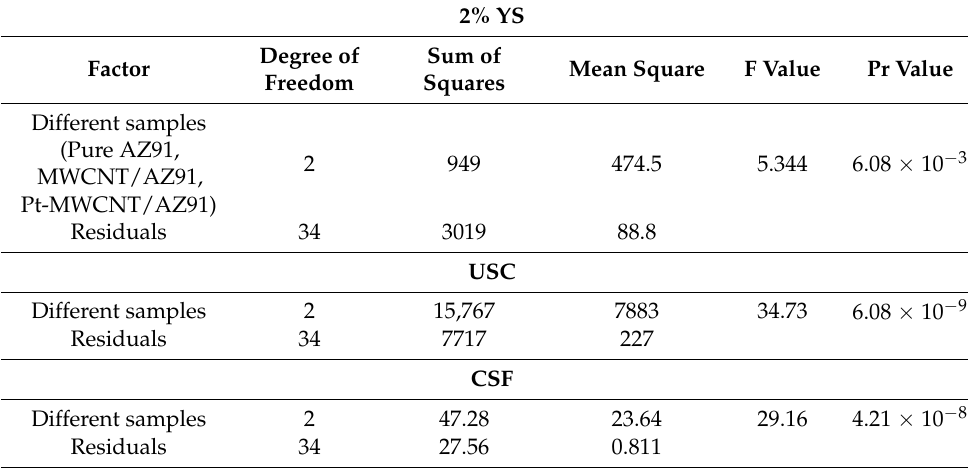
Table 2. Results of one-way ANOVA of yield strength (YS), ultimate compressive strength (UCS), and compression strain at failure (CSF) for different samples of pure AZ91, 0.05 wt% MWCNT/AZ91, and 0.05 wt% Pt-coated MWCNT/AZ91. * Significant